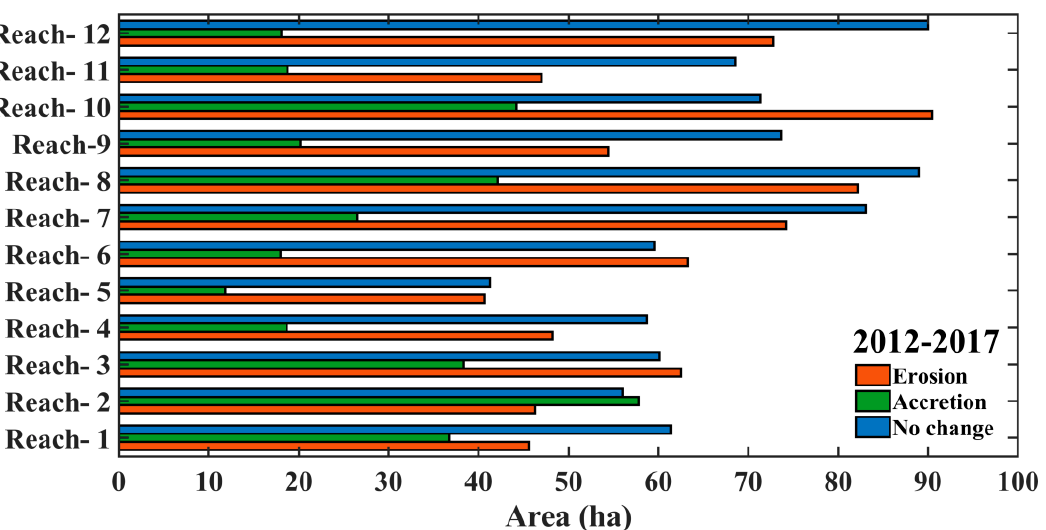
Figure 11. Map of erosion, accretion, and unchanged area between 2012–2017.